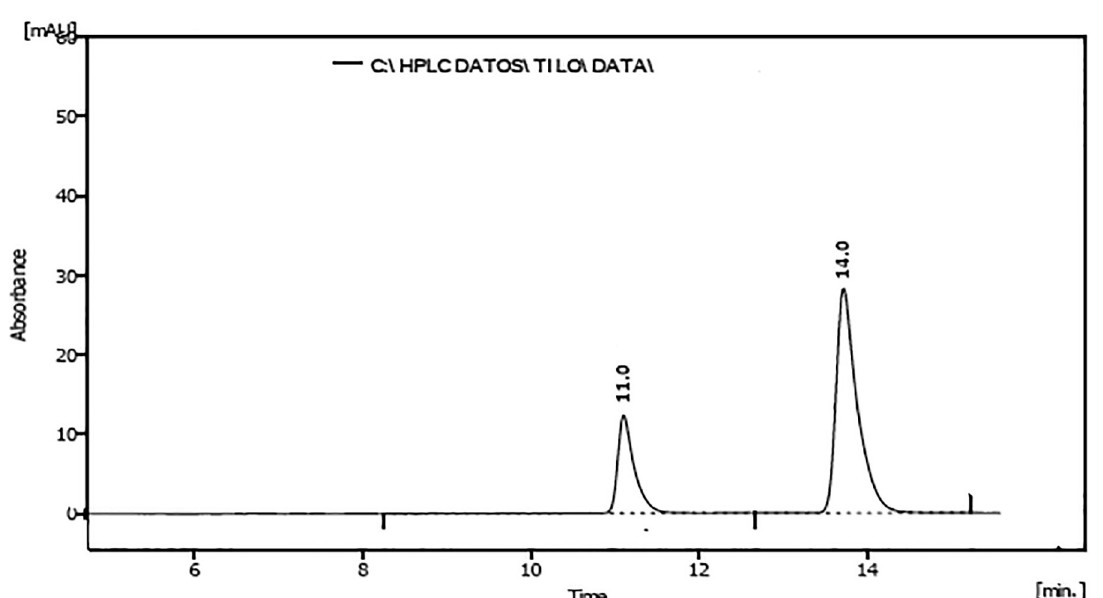
FIGURE 1 - Chromatogram of standard mixture (14,0 min: coumarin and 11,0 min: